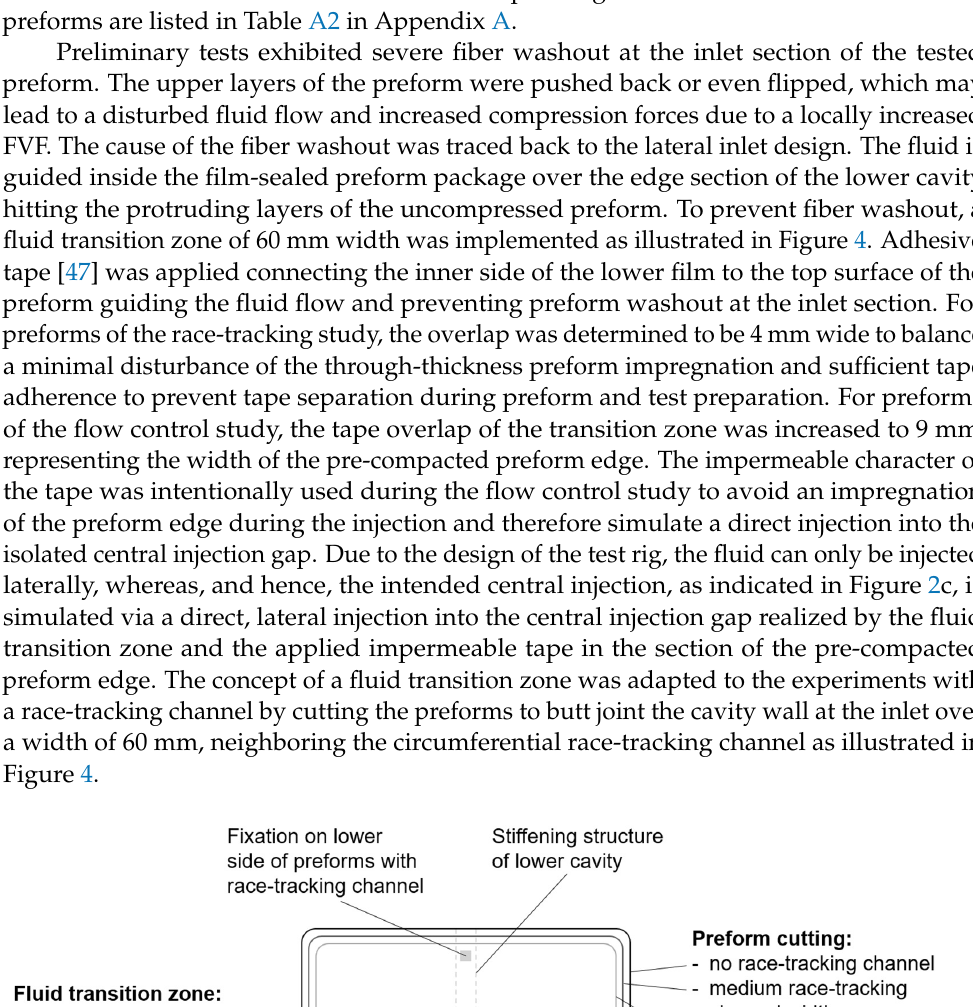
Figure 5. Components of the film-sealing station for preforms.